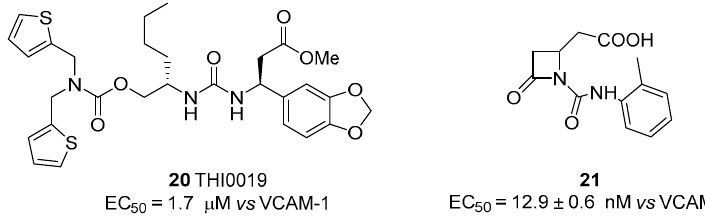
Figure 8. α 4 β 1 integrin agonists; data are expressed as EC 50 (mean ± SD, nM) vs. ligand employed in cell adhesion assay.